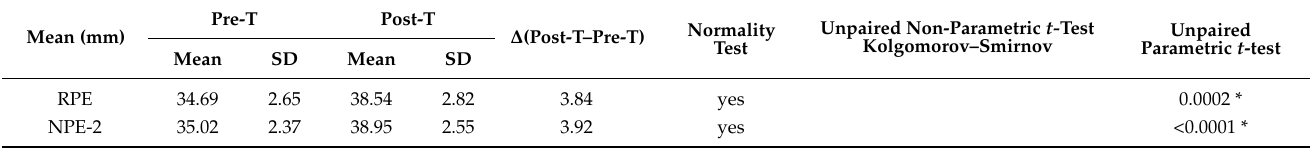
Table 3. Mean values of posterior width (McNamara’s landmarks) in patients treated with RPE and